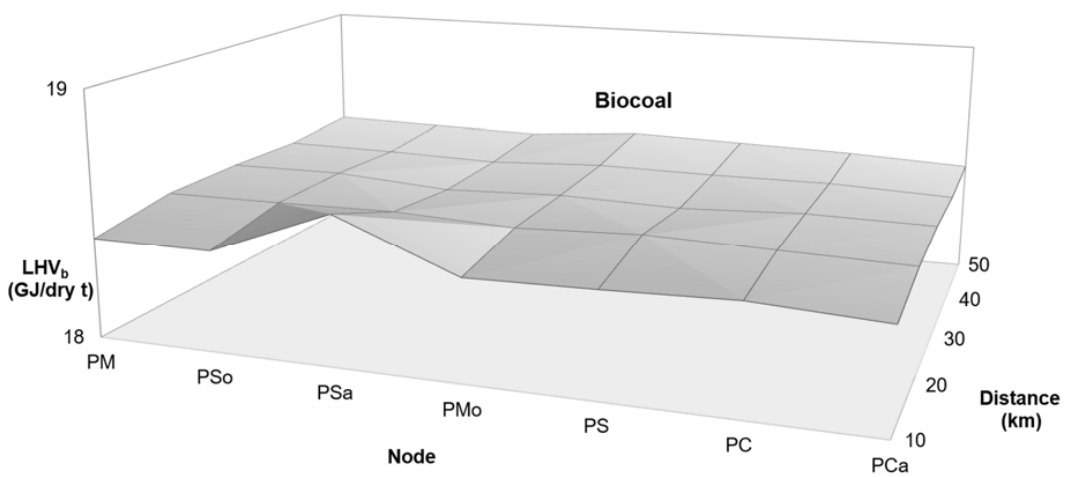
Figure 6. Lower heating value (LHV b ) distribution of the obtainable biocoal in the study area.